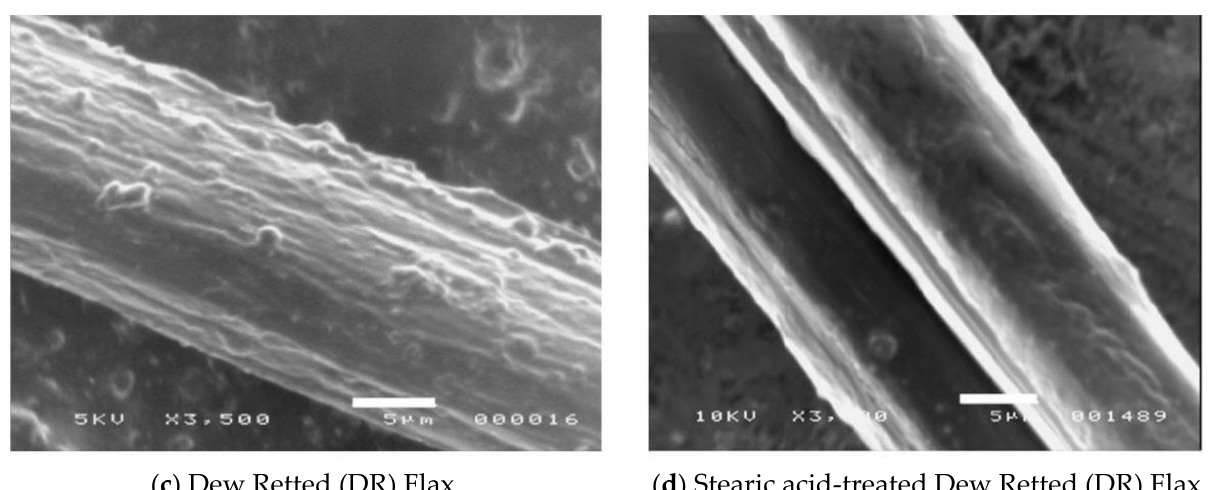
Figure 5. SEM Images of different chemical treatments on flax fiber (( a , b ) Reprinted from permission from [122]. Copyright 2021 Copyright Elsevier and ( c , d ) Reprinted from permission from [123]. Copyright 2021 Copyright Elsevier).